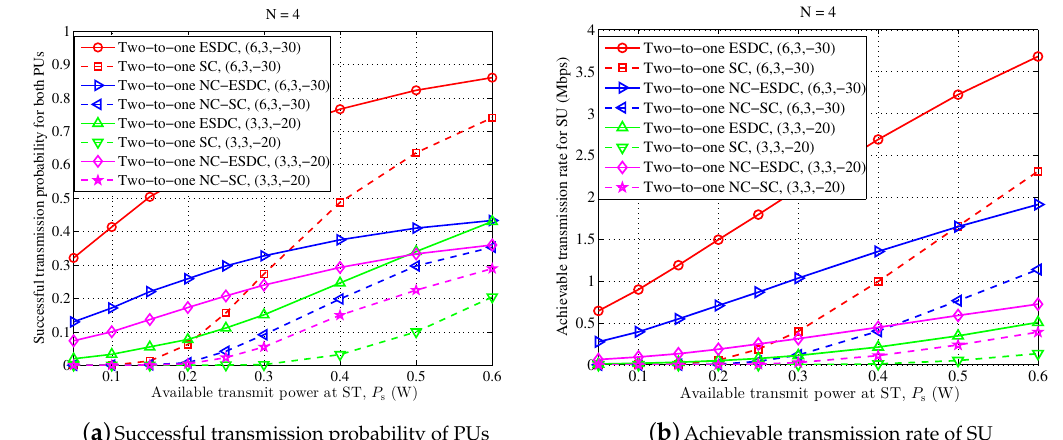
Figure 8. Performance comparison for different available battery power P th at secondary transmitter (ST), in which n = 4 and parameter setting for R p1,th (Mbps), R p2,th (Mbps) and σ 2 n (dBW) are denoted as a triple ( x , y , z ) shown in the